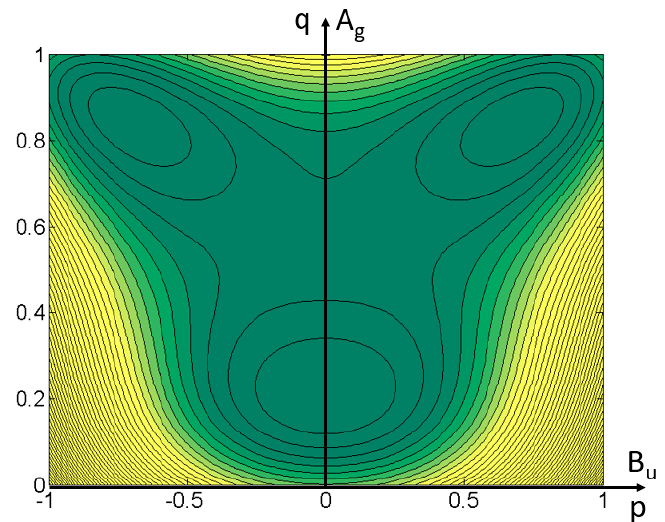
Figure 6. Schematic drawing of the Landau potential energy isolines in the 2D order parameter space around T NI (multistable regime).